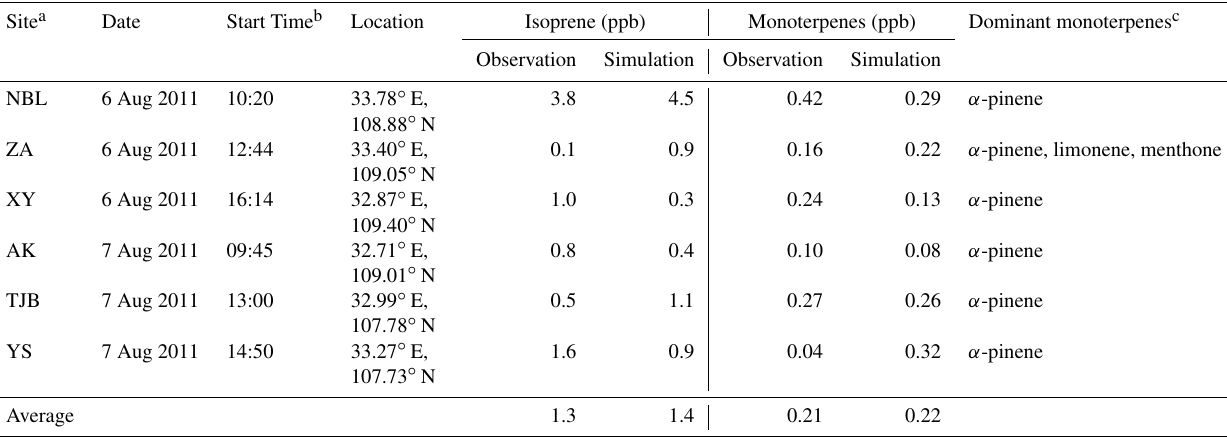
Figure 1. The simulation domain and the locations of six biogenic VOCs sites (triangles), one meteorological site (square) and one air quality site (snowflake). Colors indicate land types from MODIS. The area of red line indicates the urban area of Xi’an city. The area of blue line indicates the GZ Basin. Table 1. Ambient biogenic VOCs observations in the Qinling Mountains during 6–7 August